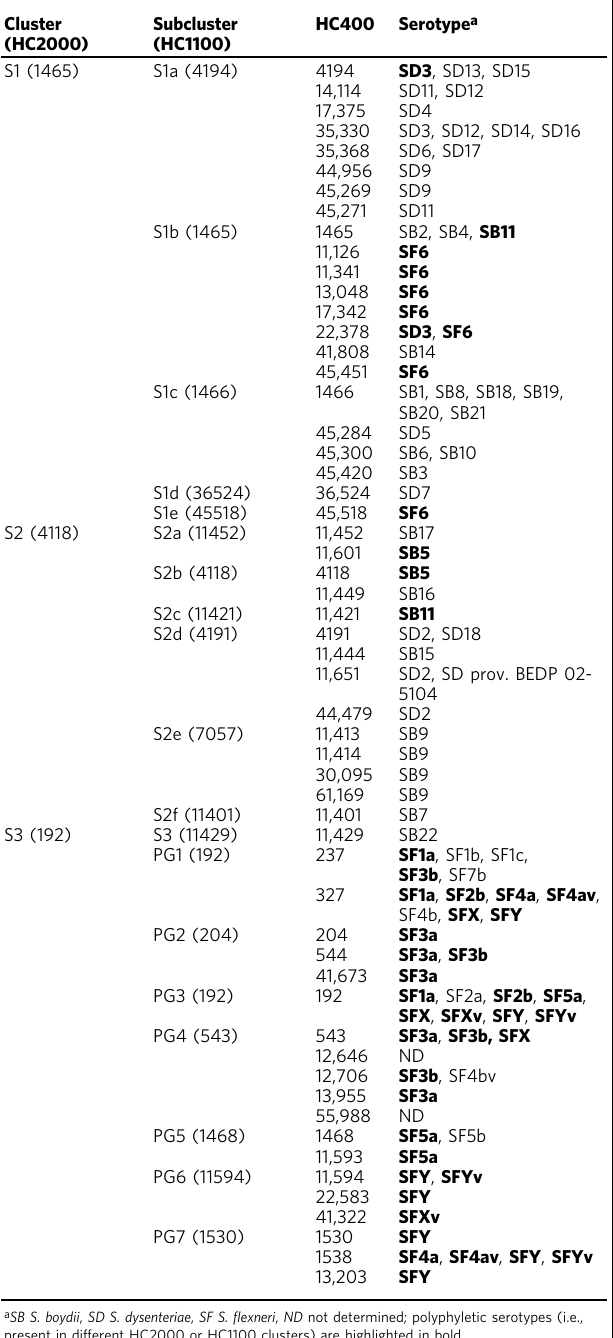
Table 1 Distribution of the different Shigella serotypes in clusters S1, S2, and S3 of 398 Shigella reference and reference + genomes according to their HC2000, HC1100, and HC400